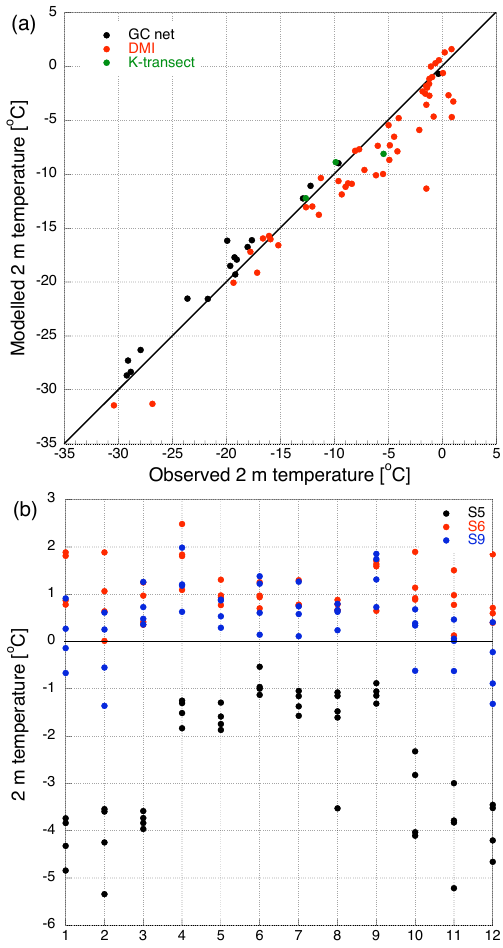
Fig. 4. Model performance for 2m temperature [ ◦ C]. (a) model versus observations for GC-net (black), DMI coastal stations (red), and K-transect (green), averaged over the available measuring pe- riod, (b) monthly model bias (2003–2007) along the K-transect for S5 (black), S6 (red) and S9